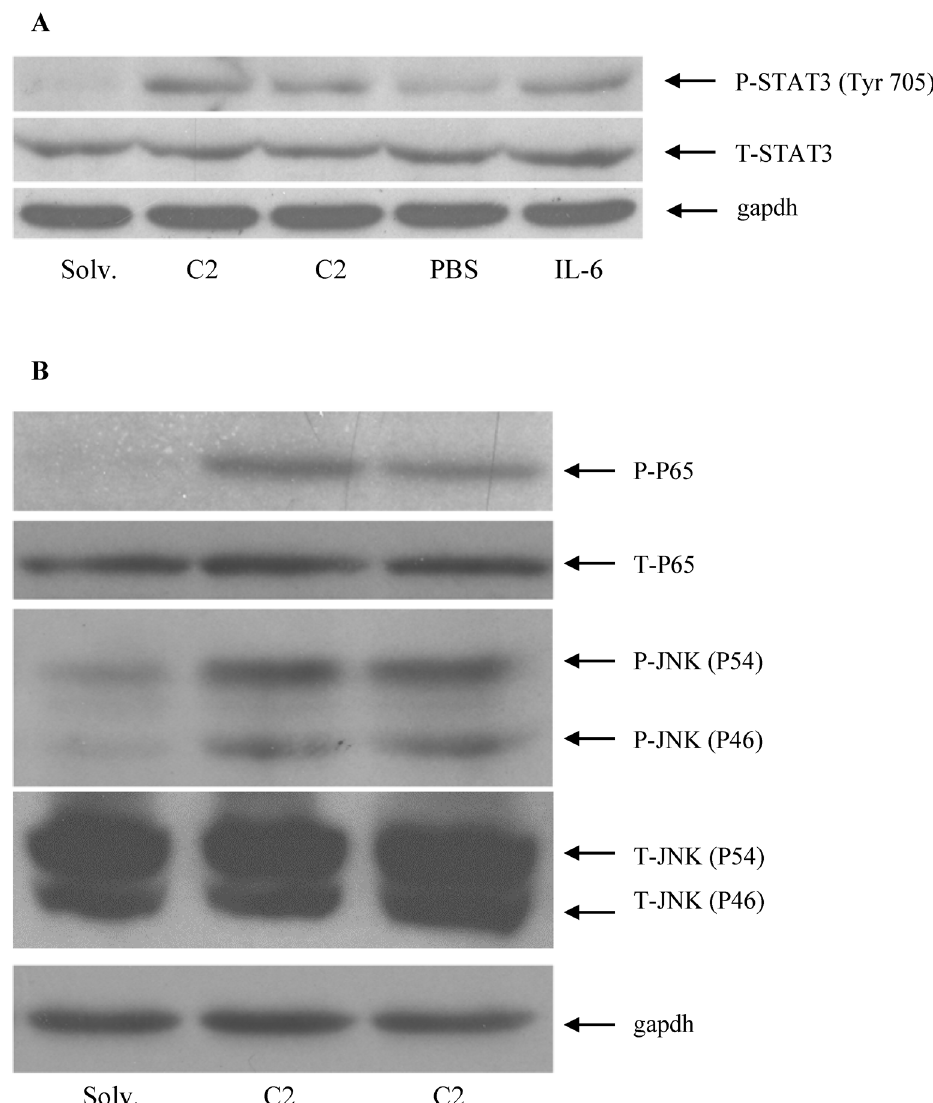
Fig 2. The effect of ceramide on the phosphorylation of STAT3, JNK and NF- κ B in HepG2 cells. Protein lysates isolated from HepG2 cells treated with 60 μ M C2 ceramide or solvent control, and 40 ng/ ml recombinant IL-6 or PBS control for 8 hours, were employed for western blotting to determine the level of total or phosphorylated proteins. Total STAT3 (T-STAT3) or STAT3 phosphorylated on tyrosine 705 (P-STAT3) ( A ), total (T-P65) or phosphorylated (P-P65) NF- κ B subunit P65, and total (T-JNK) or phosphorylated-JNK (P-JNK) ( B ) protein levels were determined by using specific antibodies. An anti-gapdh antibody was employed as a protein loading